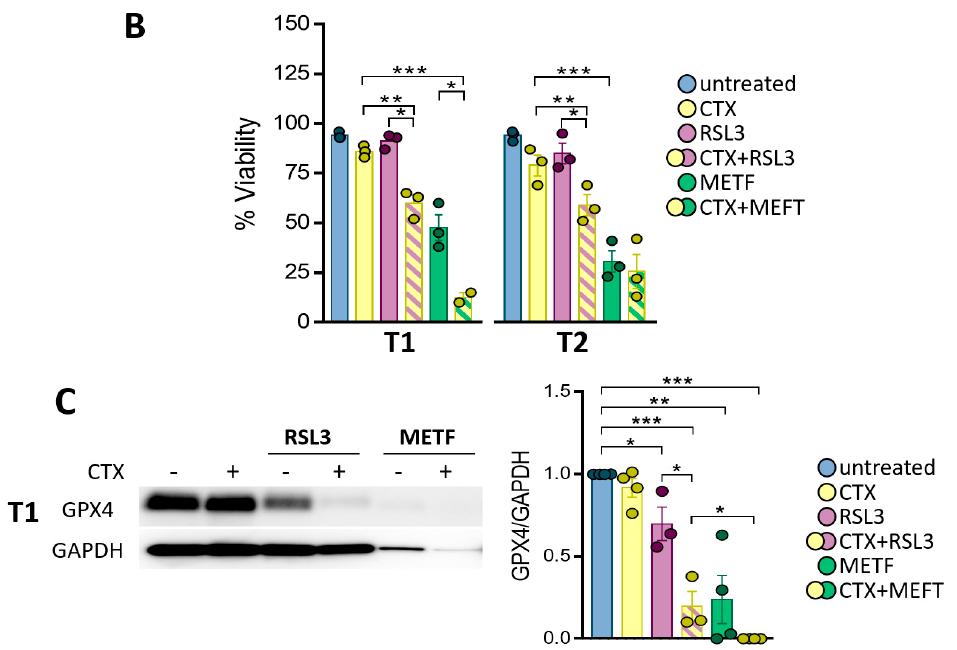
Figure 5. ( A ) Patient-derived tumoroids T1 were treated with solvent, 30 nM CTX, 5 µ M RSL3, 1 µ M metformin (METF), a combination of CTX + RSL3 or CTX + metformin. Pictures were before treatment (left panel) and 7 days after treatment with 4 × (middle panel) and 10 × (right panel) magnification. ( B ) Viability was determined after 7 days of the culture. Each bar represents the mean ± SEM of the percentage of viability ( n = 3 for T1 and T2, with * p < 0.05, ** p < 0.001, *** p < 0.0001. ( C ) Expression of GPX4 and GAPDH was determined by Western blot in T1 tumoroids treated with solvent, 30 nM CTX, 5 µ M RSL3, 1 µ M metformin (METF), a combination of CTX + RSL3 or CTX + metformin. Histograms represent the mean ± SEM ( n = 4, with * p < 0.05, ** p < 0.01 and *** p < 0.001) of the protein expression normalized with GAPDH.